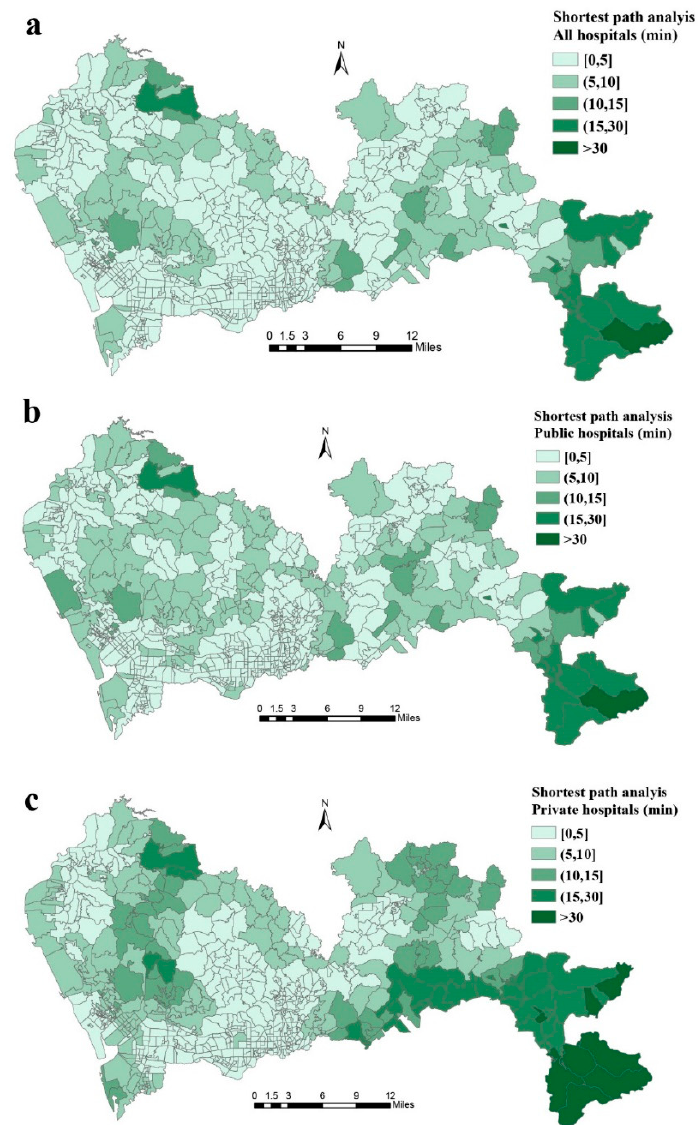
Figure 2. Travel time from community to nearest general hospital, ( a ) all hospitals, ( b ) public hospitals, ( c ) private hospitals.